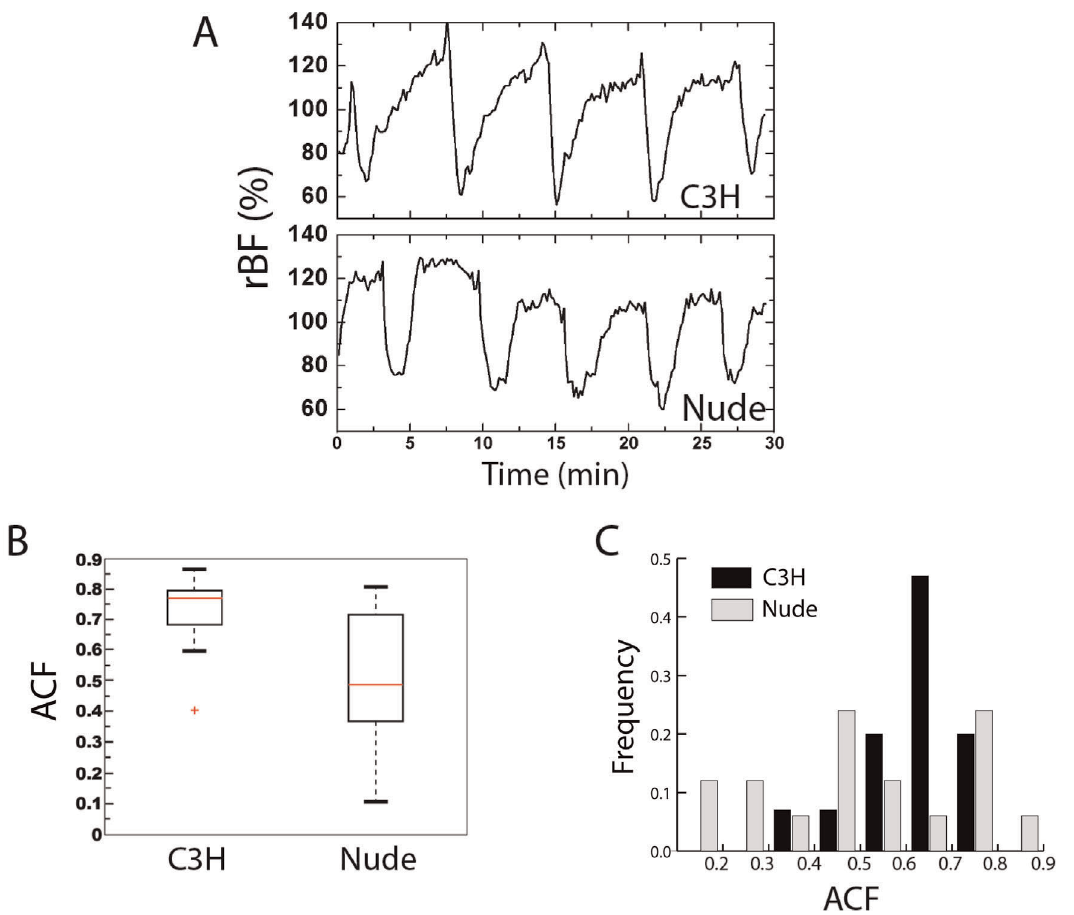
Figure 2. Cyclic tumor blood flow at baseline depends on mouse strain. (A) Representative rBF time-courses in RIF tumors for a C3H and a nude mouse during one hour of unperturbed monitoring. (B) Mean autocorrelation function (ACF) across signal-detector pairs of the first three lags (equivalent to 1 minute) for each strain; p=0.003 for the difference between the strains. (C) Histogram of the distribution of the mean ACF among the mice of each strain. (N=17/15 for nudes/C3H).